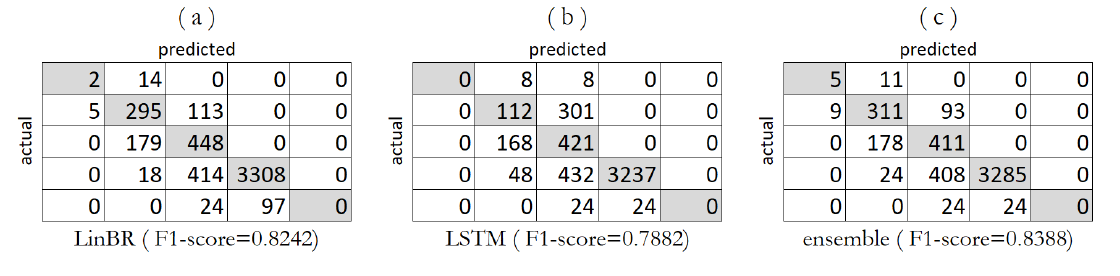
Figure 5. CAQI Confusion matrices of the best models, specifically ( a ) the linear model (LinBR, w = 24), ( b ) the LSTM model (LSTM, w = 48) and ( c ) an "ensemble" result, given by using the best predictors for each pollutant: RF for NO 2 , LSTM for O 3 , LinBR for PM 10